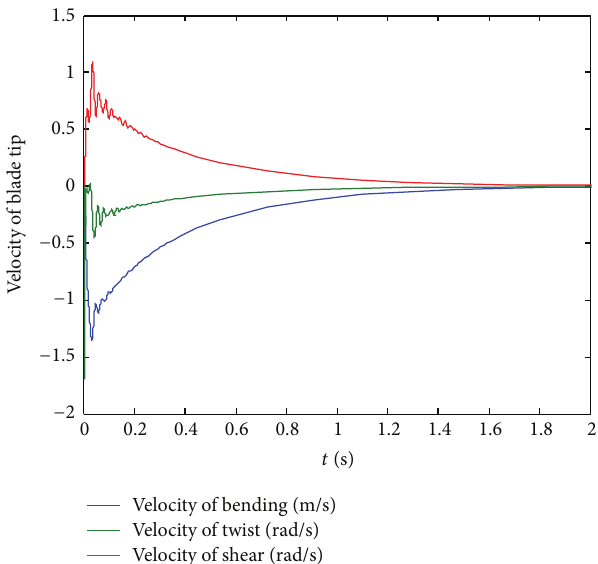
Figure 6: The three velocities at the blade